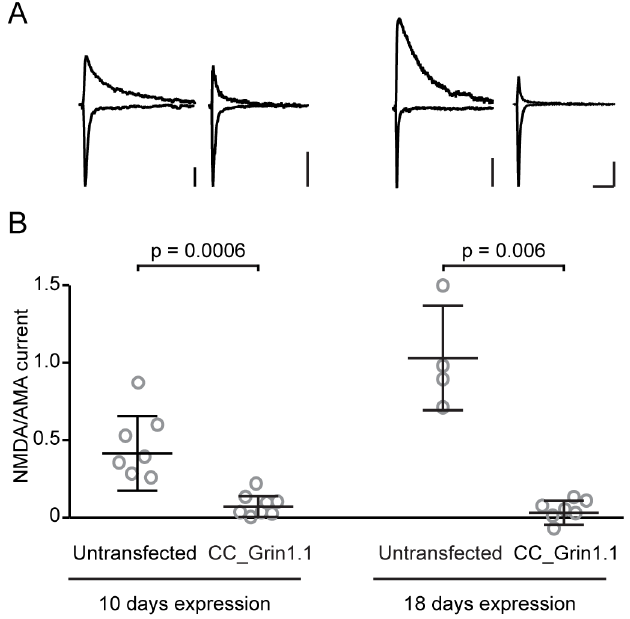
Figure 2. CRISPR/Cas9-mediated knock-down in postmitotic neurons. (A) Example traces of AMPAR currents (recorded at 2 70 mV, inward) and NMDAR currents (recorded at + 40 mV, outward) from organotypic slice cultures. Shown are examples from untransfected cells and CC_Grin1.1 transfected cells following 10 days expression (left) and 18 days expression (right). Scale bars are 20 pA (left) or 50 pA (right) and 100 ms. (B) NMDAR/ AMPAR current ratio for all cells as described before. Untransfected and CC_Grin1.1 transfected cells were compared individually for different time points, using the Mann-Whitney test.